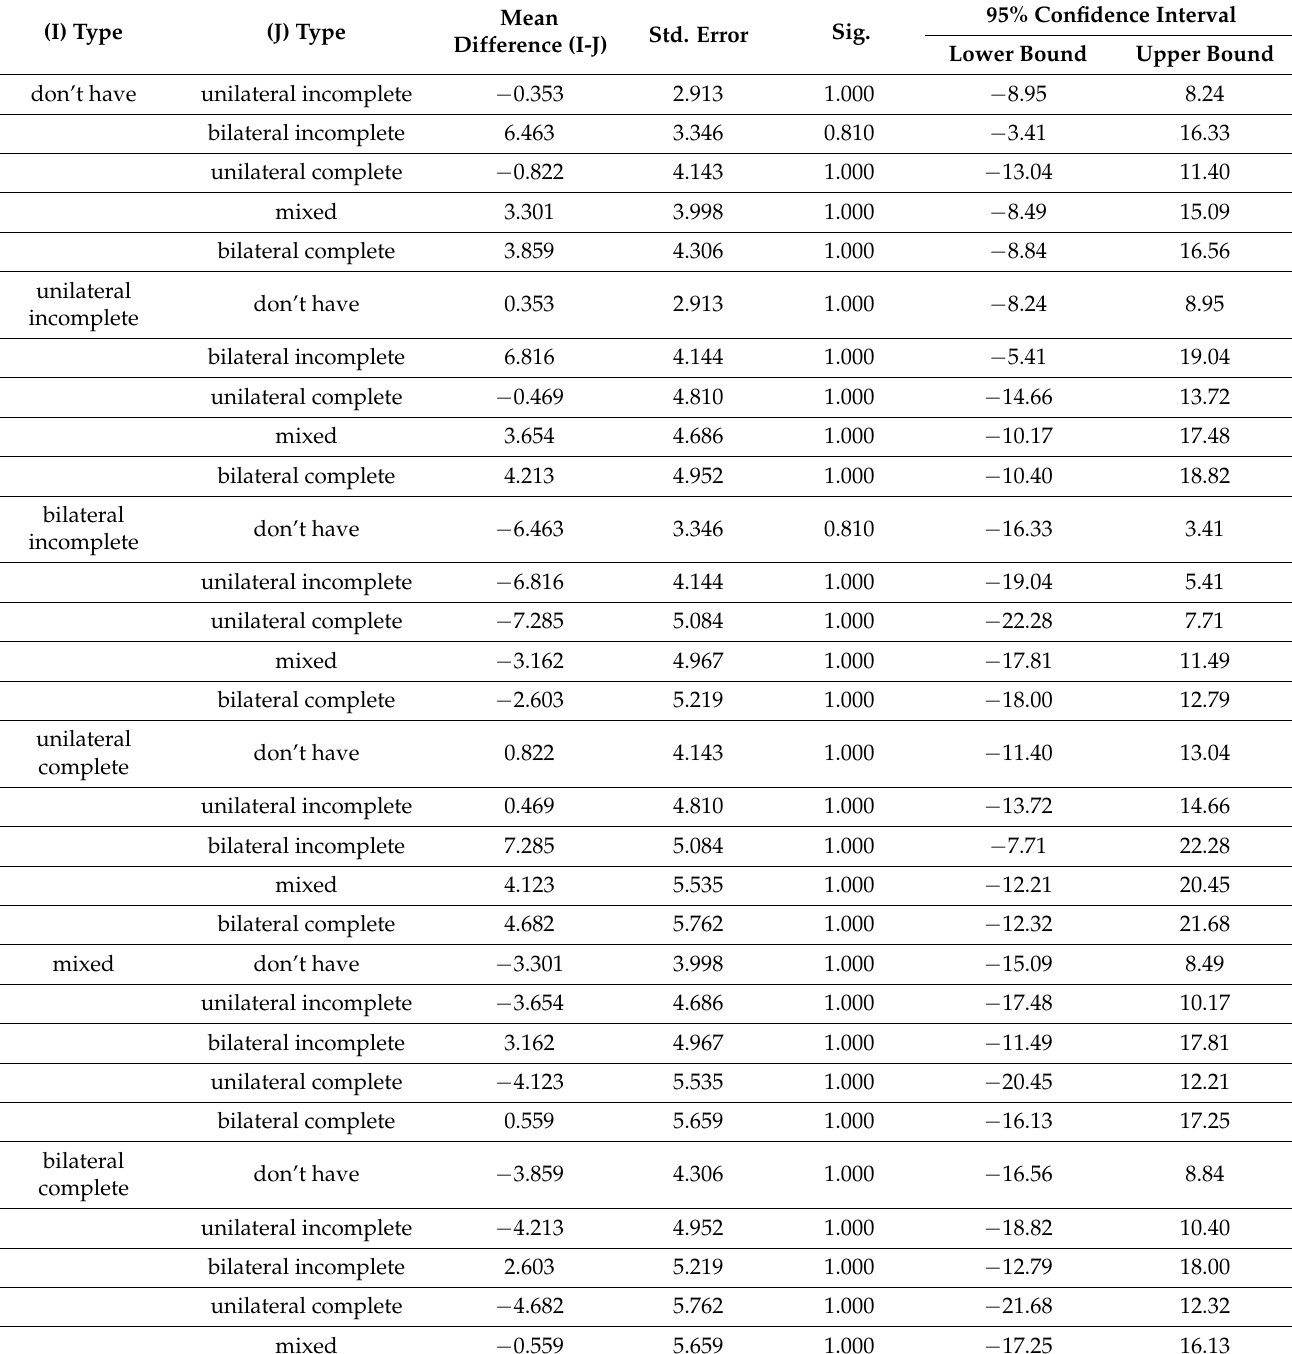
Table 6. Multiple Comparisons Bonferroni. Dependent Variable: